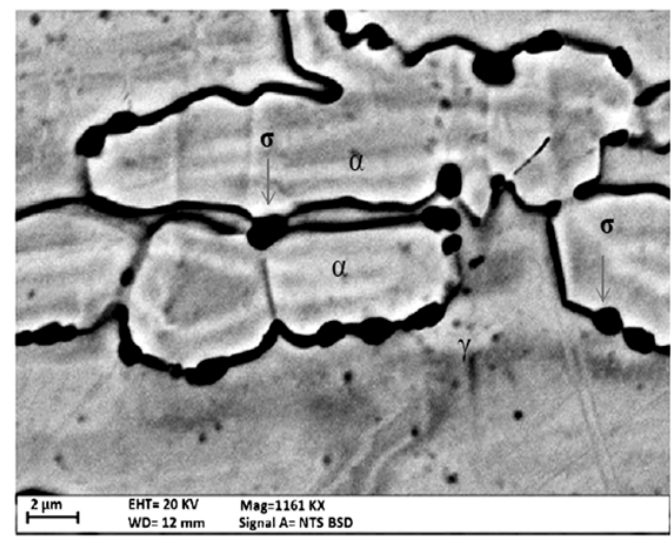
Figure 5. Microstructure of the HAZ of dissimilar weldment with 309L weld metal showing precipitates in the austenite/ferrite interface (chi and/or/sigma phase).